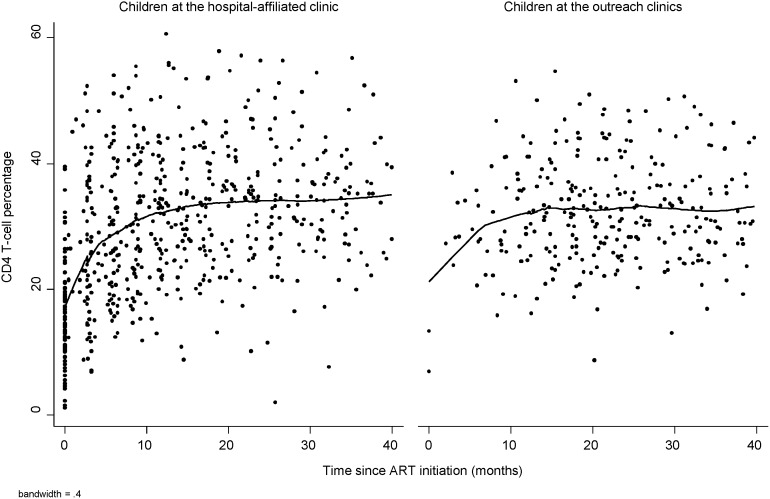
Lowess graph of CD4+ T-cell percentage by time since ART initiation for HIV-infected children at hospital-affiliated and outreach clinics.Note: Care at outreach clinics was treated as a time-varying covariate.